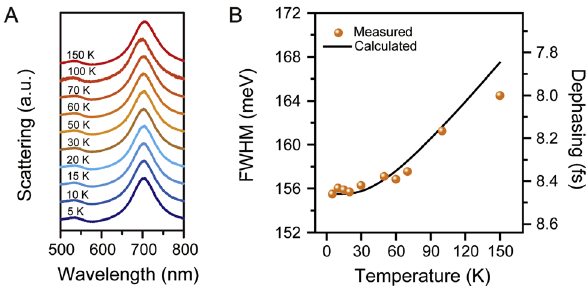
Figure 3: (A) DF scattering spectra of a NWOM with temperature varying from 5 K to 150 K. (B) The measured FWHM (orange dots) and calculated dephasing time (solid black line) of the M mode at different temperatures. The dephasing time was calculated by the Debye